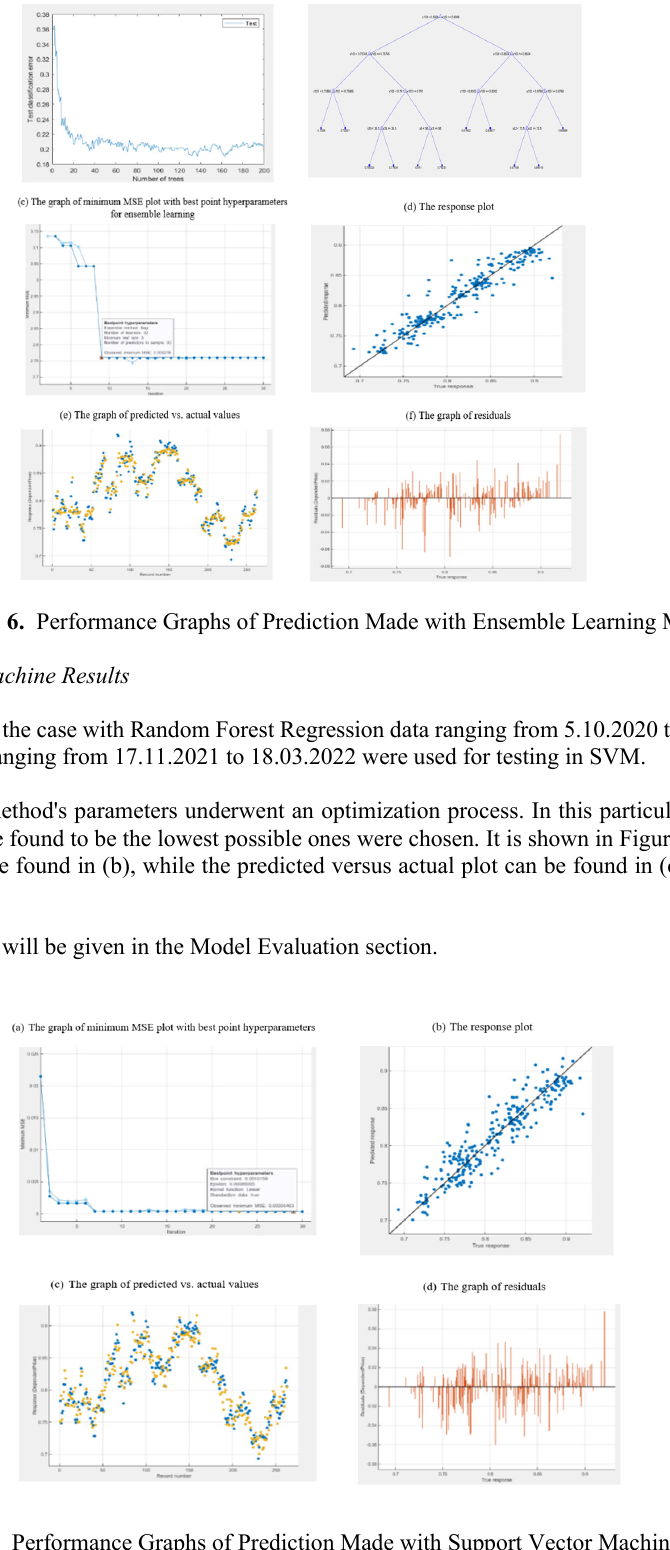
Fig. 7. Performance Graphs of Prediction Made with Support Vector Machine